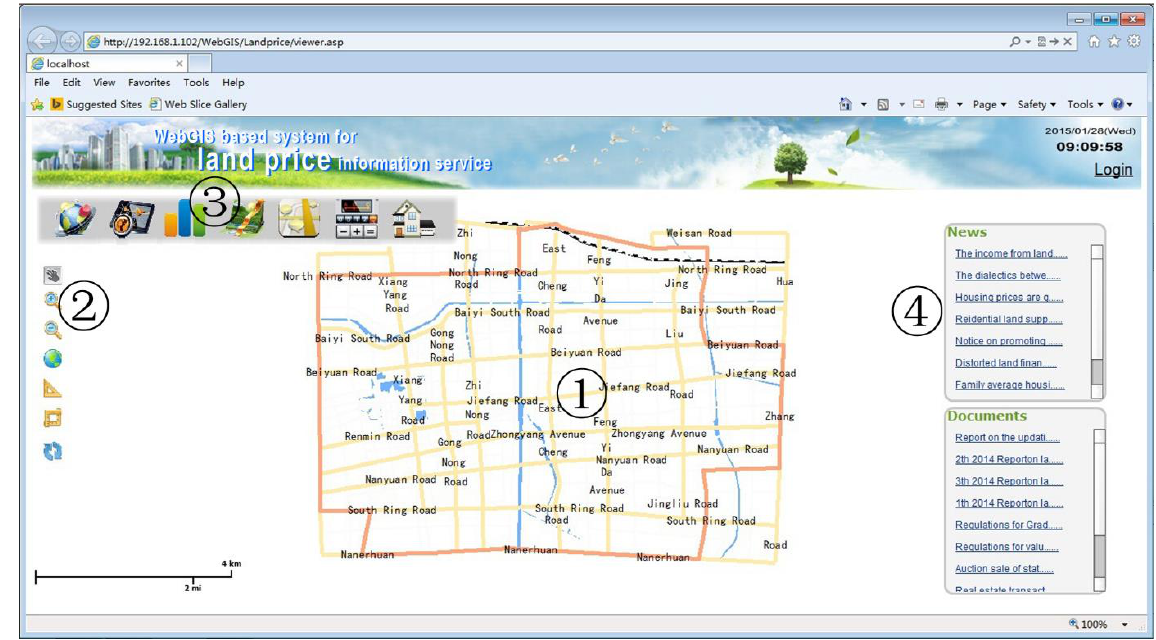
Figure 3. Main interface of the prototype